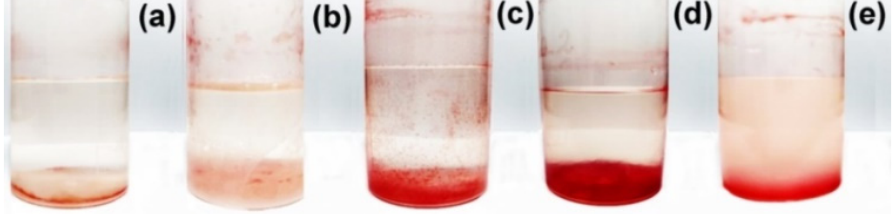
Figure 7. Images of the polysaccharide formulations after 1 month of incubation with B. subtilis in the presence of TTC at 28 ° С : ( a ) ALG; ( b ) dispersion of anionic complexes with Q 2 = [QHECE]/[ALG] = 0.1; ( c ) QHECE; ( d ) dispersion of cationic complexes with Q 1 = [ALG]/[QHECE] = 0.2; ( e ) dispersion of cationic complexes with Q 1 = [ALG]/[QHECE] = 0.6.